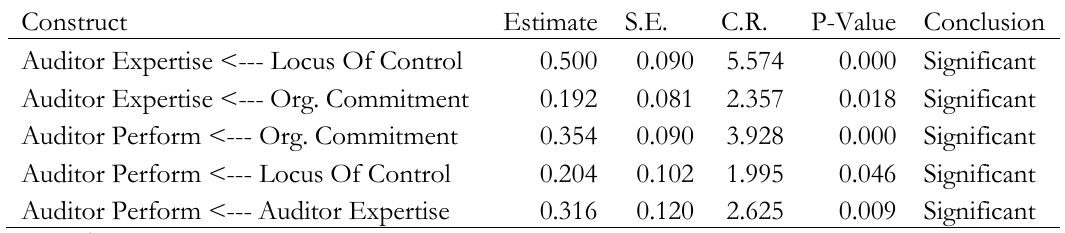
Table 4. Significance test of the effect between